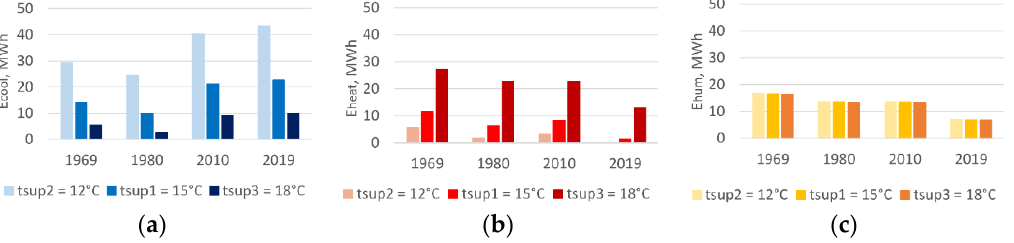
Figure 10. Annual energy demand: ( a ) cooling, ( b ) heating and ( c ) humidification for three supply air temperature variants.